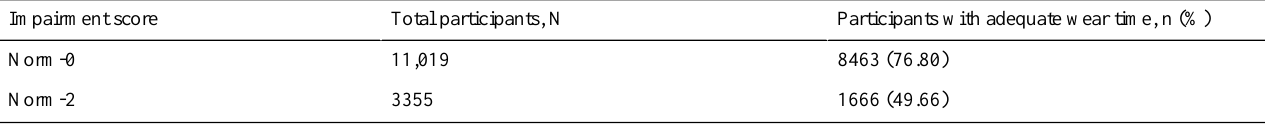
Table 1. Number of participants in each subpopulation according to activity impairment severity